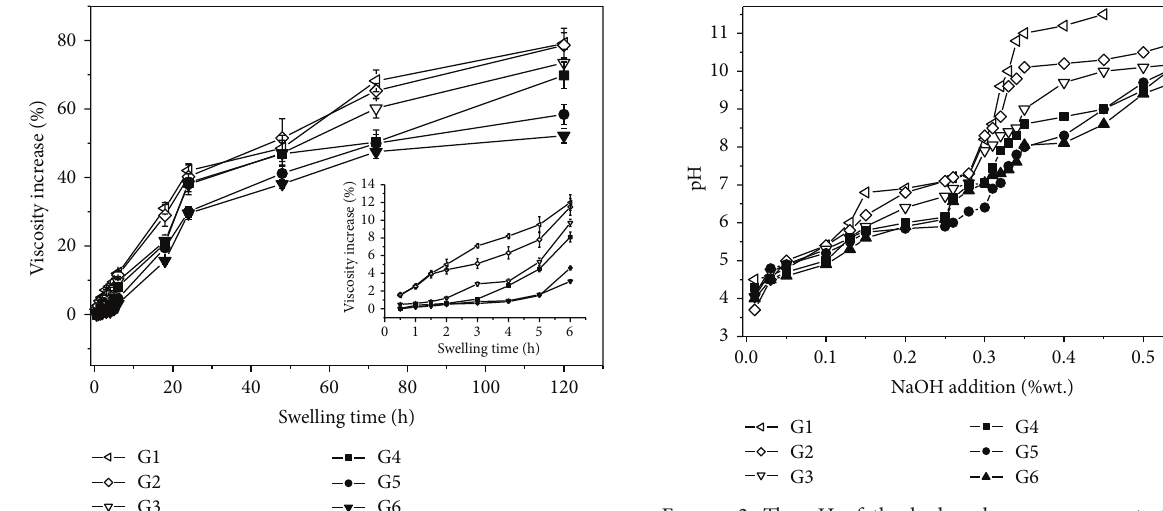
Figure 2: The pH of the hydrogels versus concentration of the neutralizer